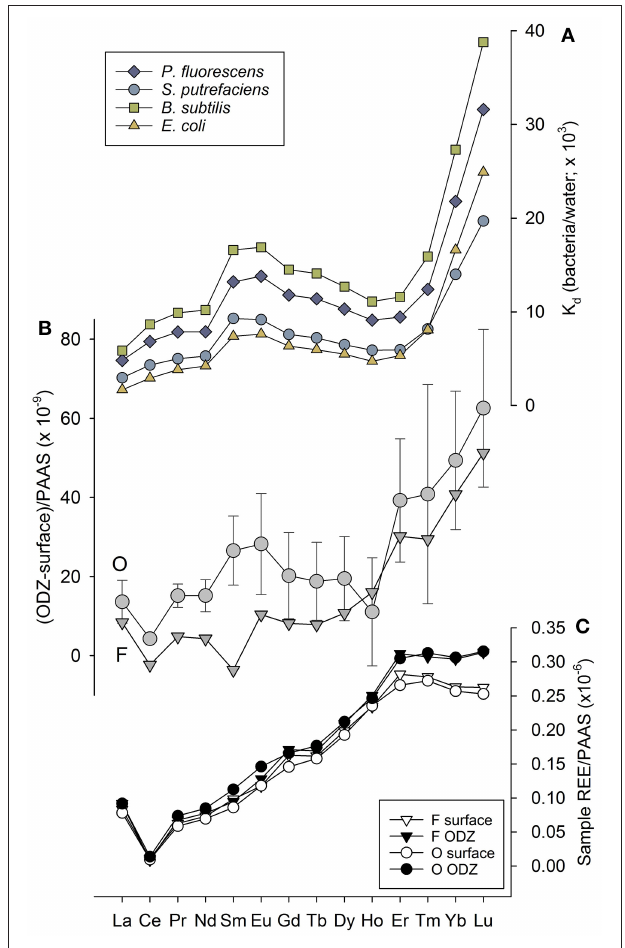
FIGURE 13 | Comparison of (A) the REE partitioning behaviour from water to bacteria, with (B) the PAAS-normalised difference between ODZ and surface REE concentrations. For clarity, the 1SD propagated errors are shown for station O data only. (C) The PAAS-normalised distribution profiles of F and O showing only the surface and ODZ data to highlight the lower REE concentrations in the surface waters. The REE partitioning data in (A) are from Takahashi et al. (2005) and Takahashi et al. (2007), from experiments carried out at pH 4 and I = 0.01M NaCl. To note, surface samples from O were not